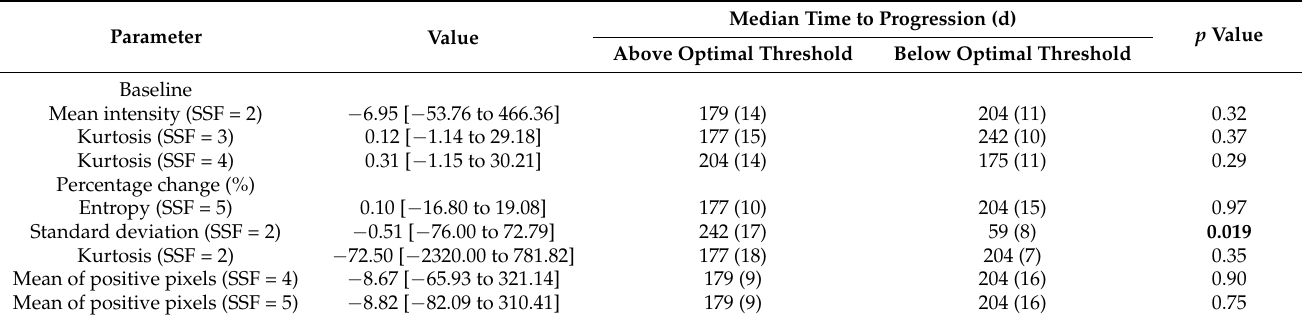
Table 8. Univariate Kaplan-Meier analysis of texture parameters for predicting survival in the validation cohort.